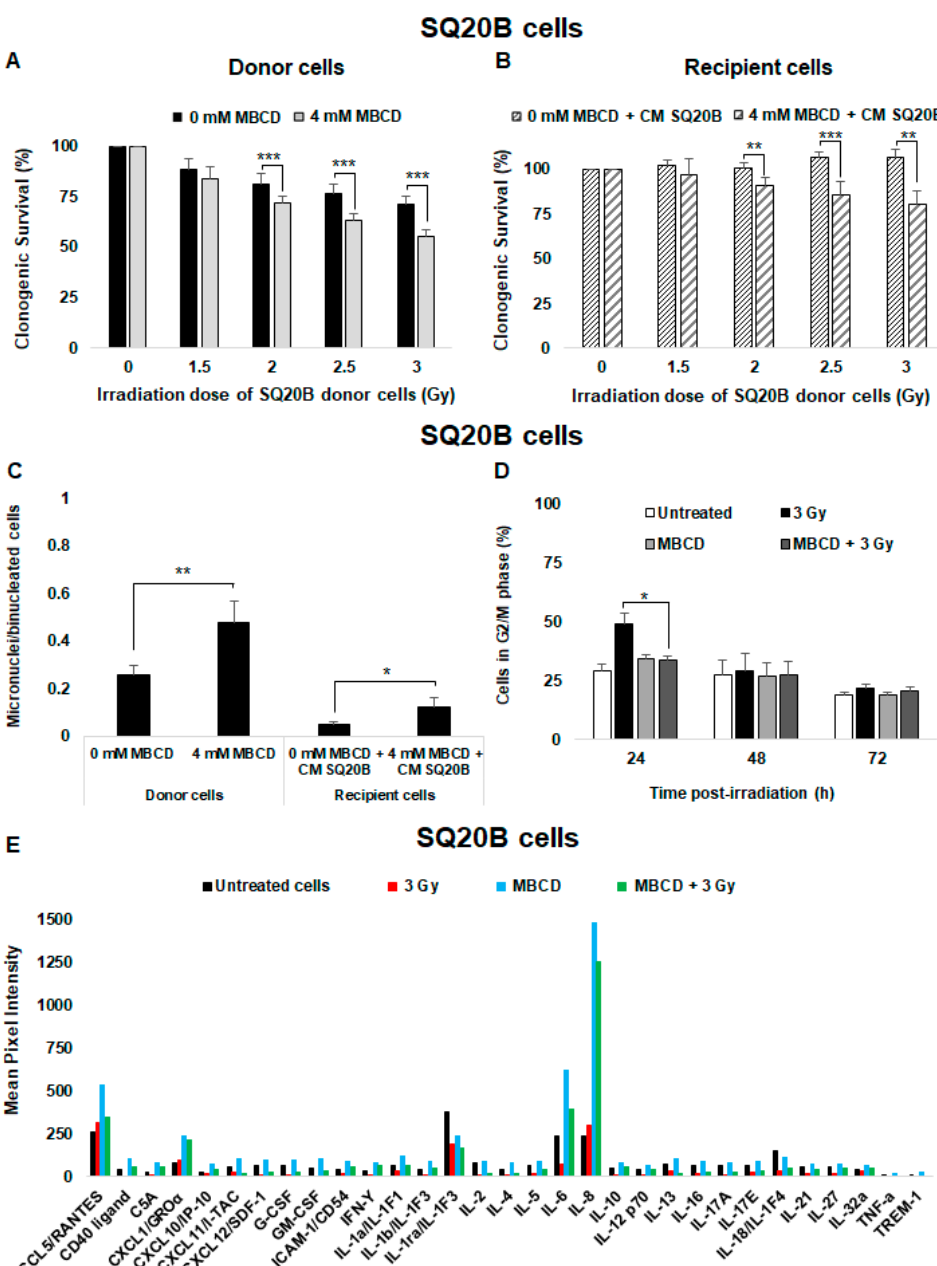
Figure 5. Lipid raft disruption sensitizes SQ20B donor cells to radiation and induces nontargeted effects. SQ20B donor cells were preincubated for 60 min with 4 mM MBCD (lipid raft disruptor) before irradiation in the presence of MBCD. After irradiation, the medium was removed and ( A ) clonogenic survival was determined in donor cells. ( B ) Clonogenic survival of SQ20B recipient cells was co-incubated or not with MBCD before transfer of the CM from SQ20B donor cells. ( C ) The number of micronuclei per cell in SQ20B donor and recipient cells in the presence or absence of MBCD was quantified. ( D ) The percentage of cells in G2/M phase was determined using flow cytometry in SQ20B donor cells in the presence or absence of MBCD. The results are the mean ± SD of three experiments performed in triplicate. * p < 0.05, ** p < 0.01, and *** p < 0.001 compared with cells treated only with radiation. ( E ) The expression of cytokines secreted in the CM from untreated, irradiated (3 Gy), and MBCD + irradiated SQ20B cells was evaluated using the Human Cytokine Array (Proteome Profiler Array; R&D Systems, Minneapolis, MN, USA). For each cytokine, ImageJ software was used to determine pixel